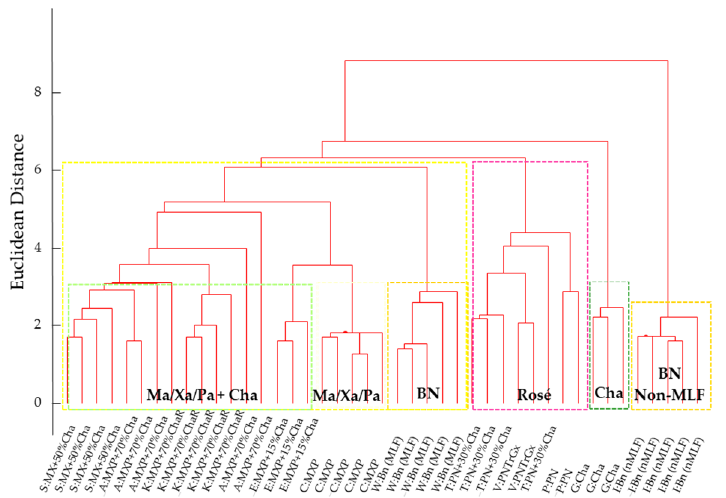
the Figure 4. HCA results from the data fusion approach using phenolic and organic acid values as the data.